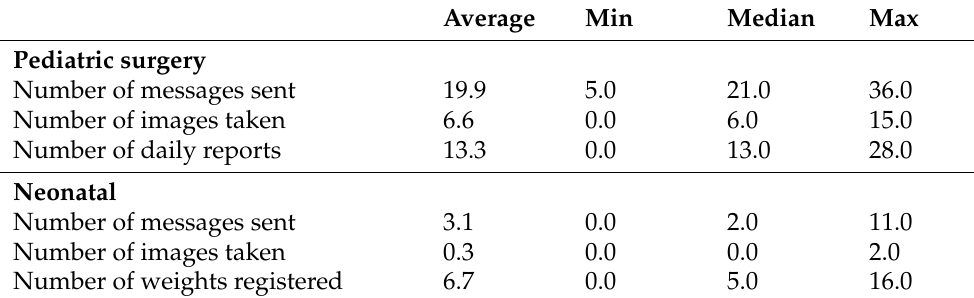
Table 2. Per family-usage of eHealth device, including data obtained from 18 eHealth devices provided to 18 families, whereof 9 from pediatric surgery and 9 from neonatal care. The eHealth device was used median 2.5 (2–5) weeks per